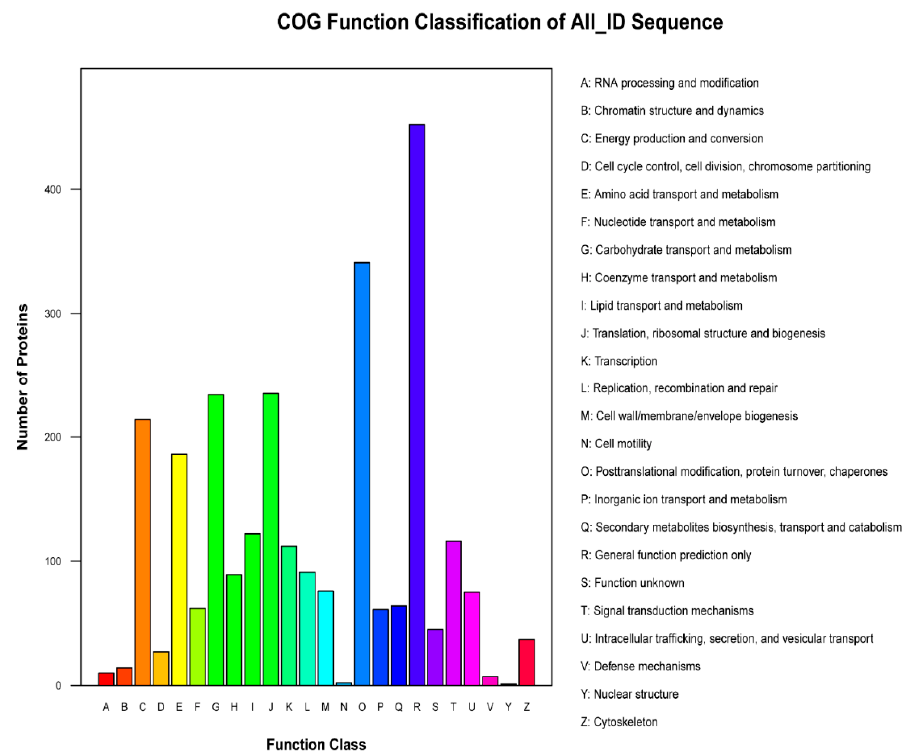
Figure 3. Cluster of Orthologous Groups (COG) function classification histogram of S727 and S3057 DEPs. The x -axis indicates different classification groups and the y -axis indicates the number of proteins in each COG class.